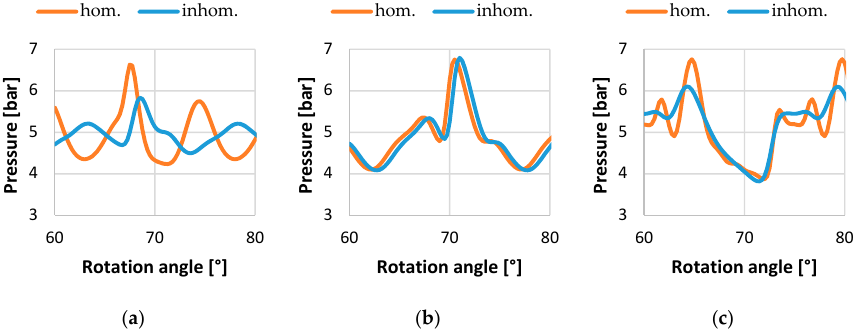
Figure 23. Difference between homogeneous and inhomogeneous multiphase approach for the instantaneous displacement chamber pressure ripple at 5-bar delivery pressure and 2000 rpm at ( a ) inlet gas volume fraction (IGVF) = 5%, ( b ) IGVF = 20%, and ( c ) IGVF = 40%.